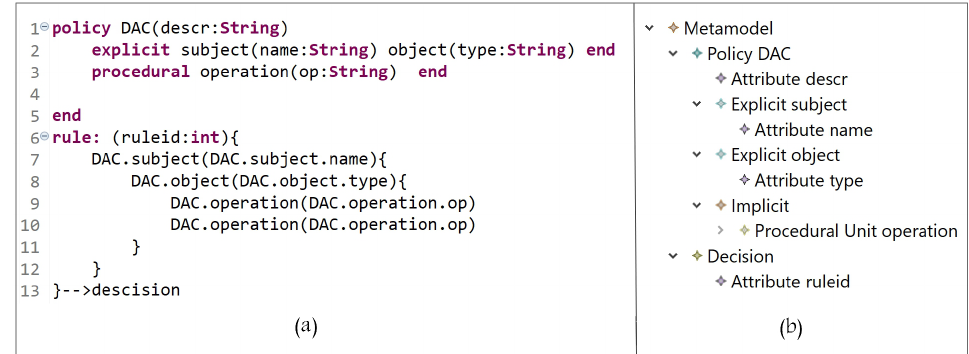
Figure 7. ( a ) DAC Policy Definition; ( b ) DAC